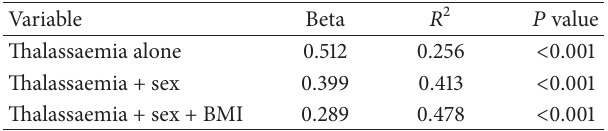
Table 4: Stepwise multiple regression analysis between serum leptin levels and different variables in 𝛽 -TM patients.